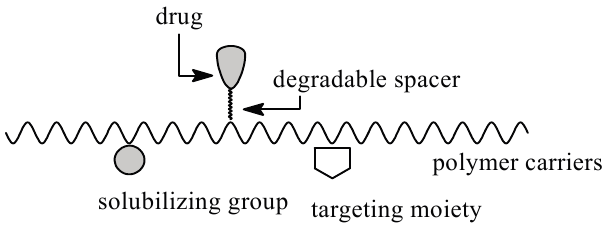
Figure 1. Polymer-drug conjugate model proposed by